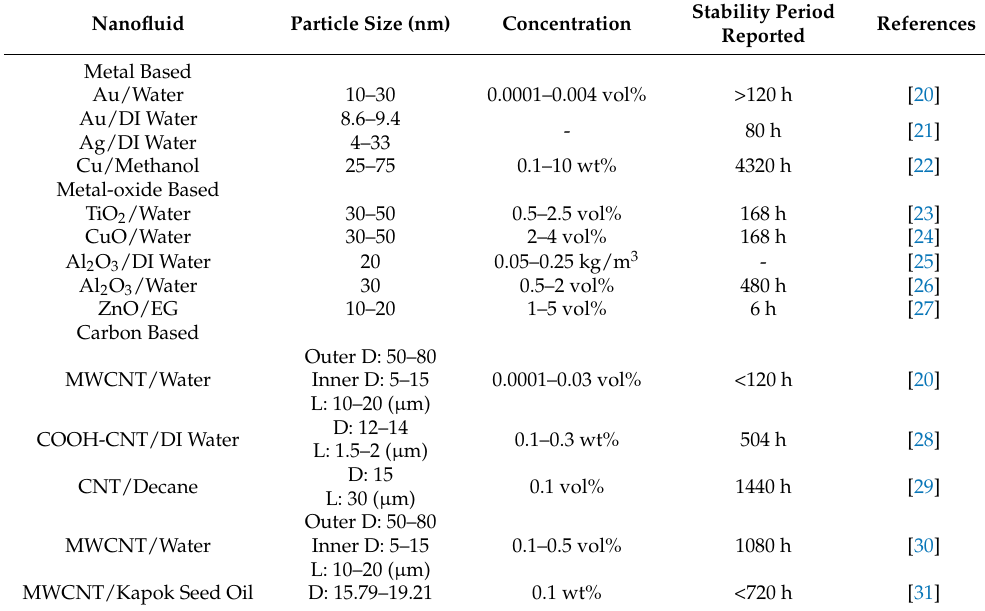
Table 4. Stability period along with nanoparticles properties from past